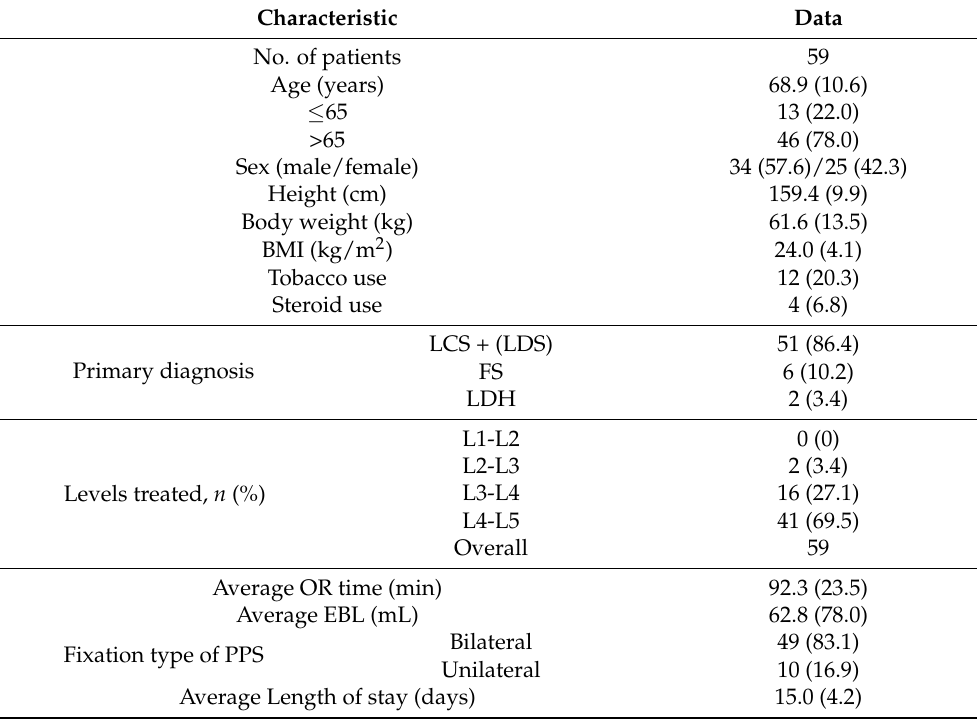
Table 1. Patient demographic and treatment information in the present study. Data presented as mean (SD) or number of patients (%). BMI, body mass index; OR, operation; EBL, estimated blood loss; LCS, lumbar canal stenosis; LDS, lumbar degenerative spondylolisthesis; DLS, degenerative lumbar scoliosis; FS, foraminal stenosis; LDH, lumbar disc herniation; ASD, adjacent segment disease.